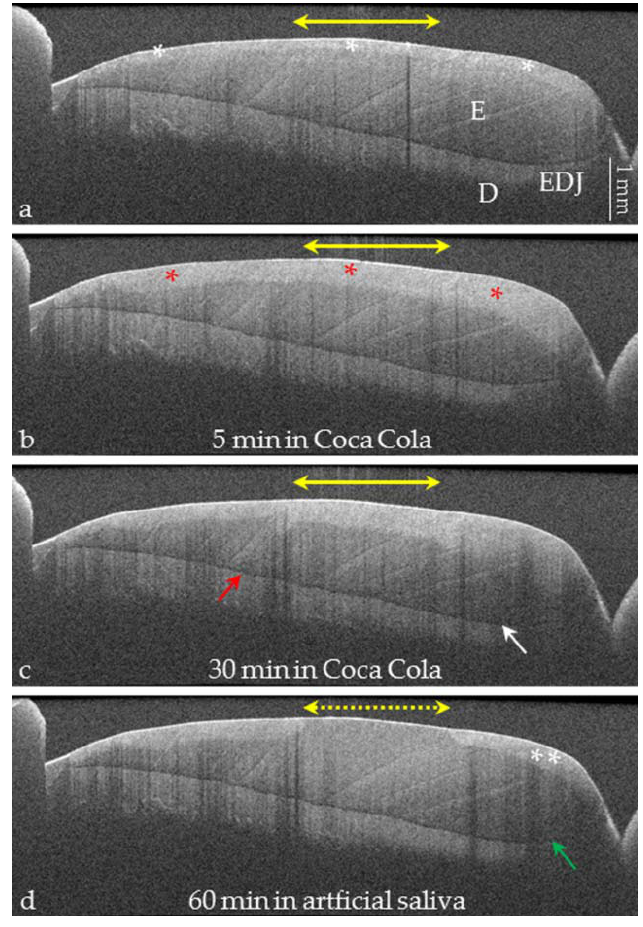
Figure 13. Extracted human incisor. ( a ) Starting situation. The SD ‐ OCT shows a small bright band in the enamel surface (E), which could represent a lower mineralized zone (white asterisks). The yellow double ‐ headed arrow indicates the surface area, which was covered by composite to prevent demineralization of the enamel; ( b ) After 5 min exposure of enamel to Coca Cola (37 °C) a broader bright area (red asterisks) can already clearly be distinguished, which represents a zone of erosion that also extended below the composite coating; ( c ) After 30 min of exposure, the demineralization has made further progress, which is indicated by the reduced contrast at the enamel ‐ dentin junction (EDJ, red arrow) or its disappearance (white arrow); ( d ) After removal of the composite coating the tooth was stored in artificial saliva. Within 60 min, the bright demineralized area previously covered by composite (dotted double ‐ headed arrow) completely disappeared indicating a process of repair (“remineralization”). In uncovered areas, the EDJ appears in a higher contrast compared to ( c ) and is more extended (green arrow). Particularly in the incisal area, the erosion is clearly reduced (**) compared to ( b , c ).